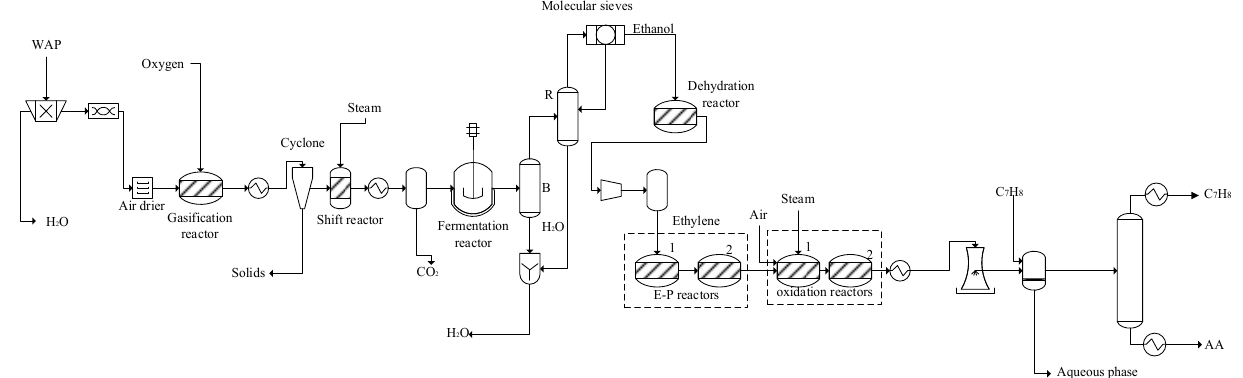
Figure 1. Simplified process flow diagram for acrylic acid production from waste apple pomace using the fermentation–dehydration (FD) pathway involving LA production as a precursor to AA production.